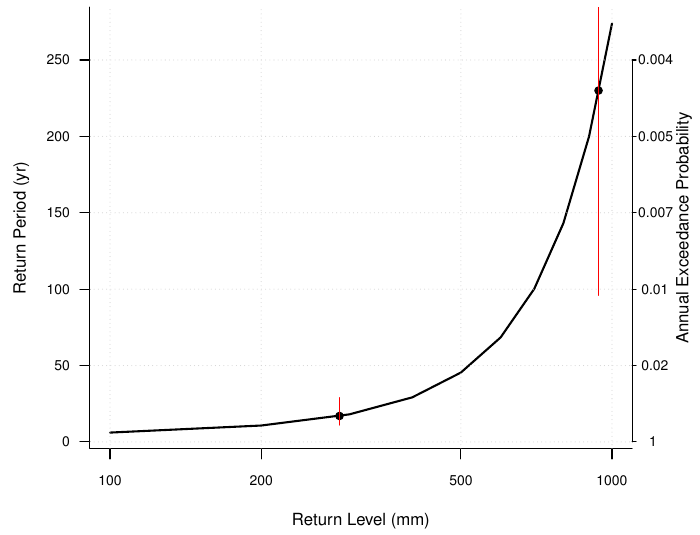
Figure 10. Tropical cyclone rainfall return frequency for Houston, Texas. Return level in mm is shown on the x-axis, return period in years is shown on the y-axis. Annual probability is also included. Red lines about the points indicate confidence bounds at the 90th percentile. Points indicate the 90th percentile rainfall amount and Harvey in 2017.